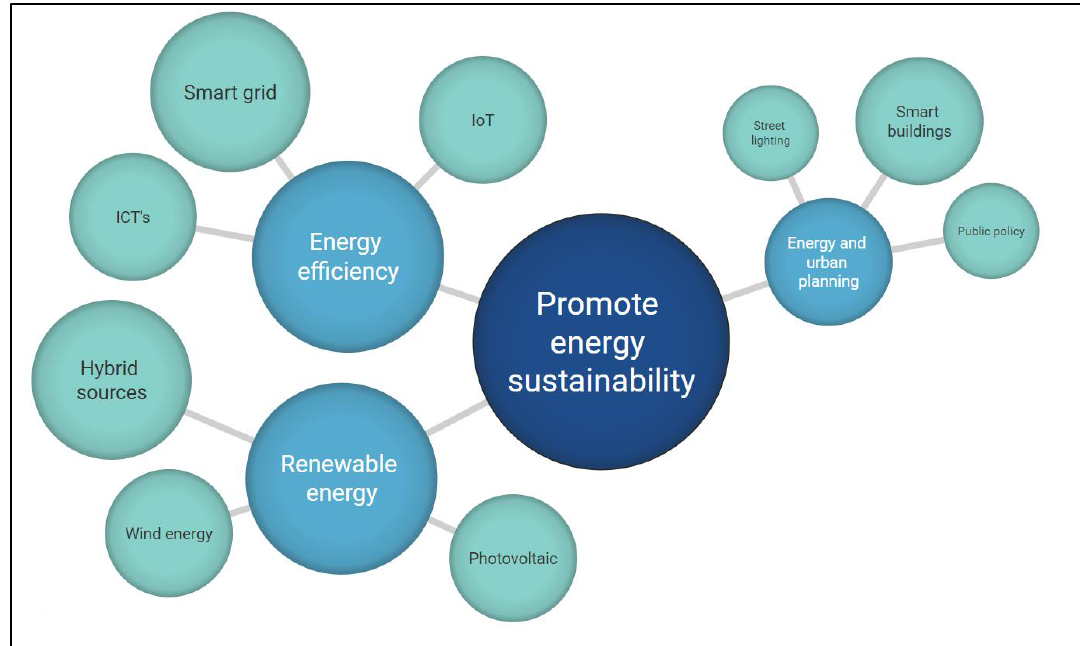
Figure 5. Main categories concerning sustainable energy in the context of smart cities.